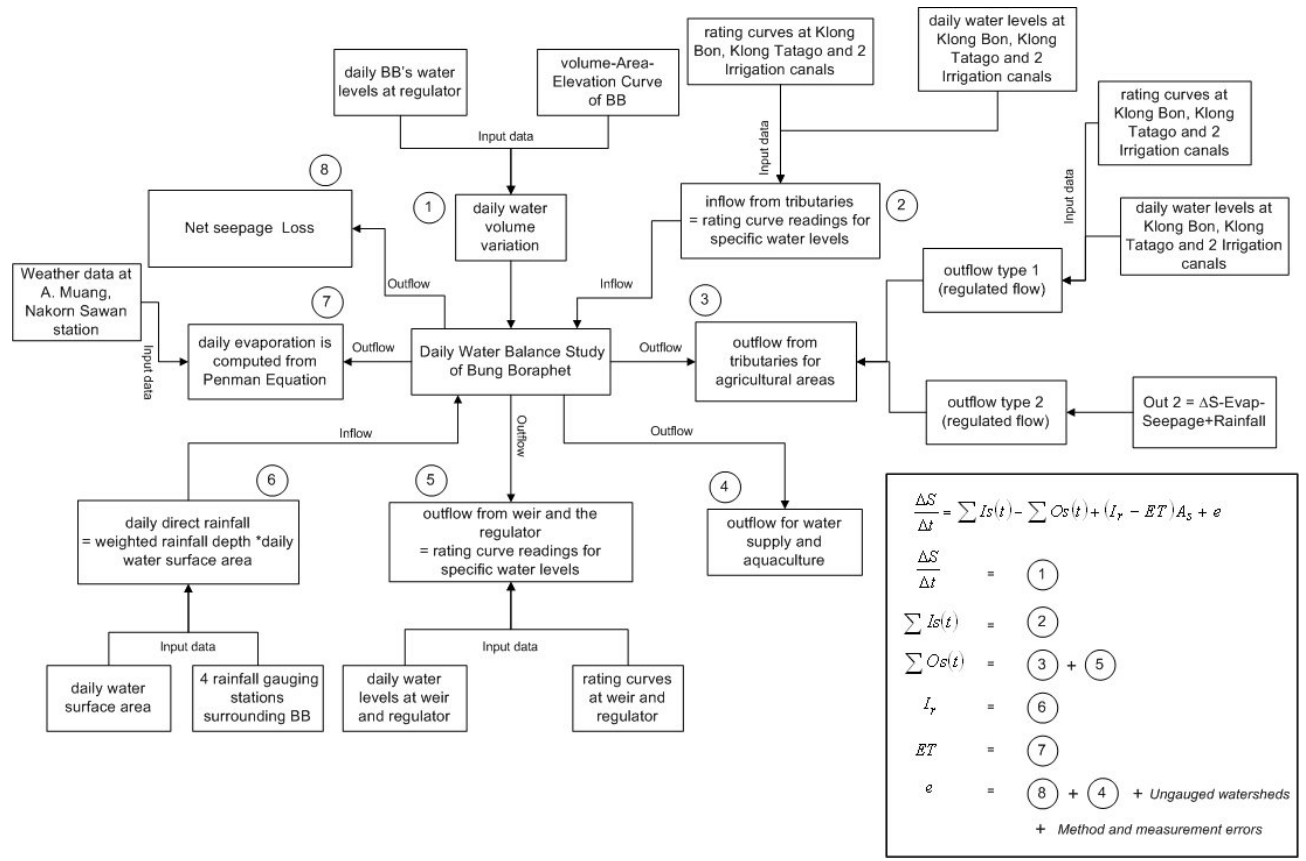
Figure 3. Process model for calculating the daily water budget for Bung